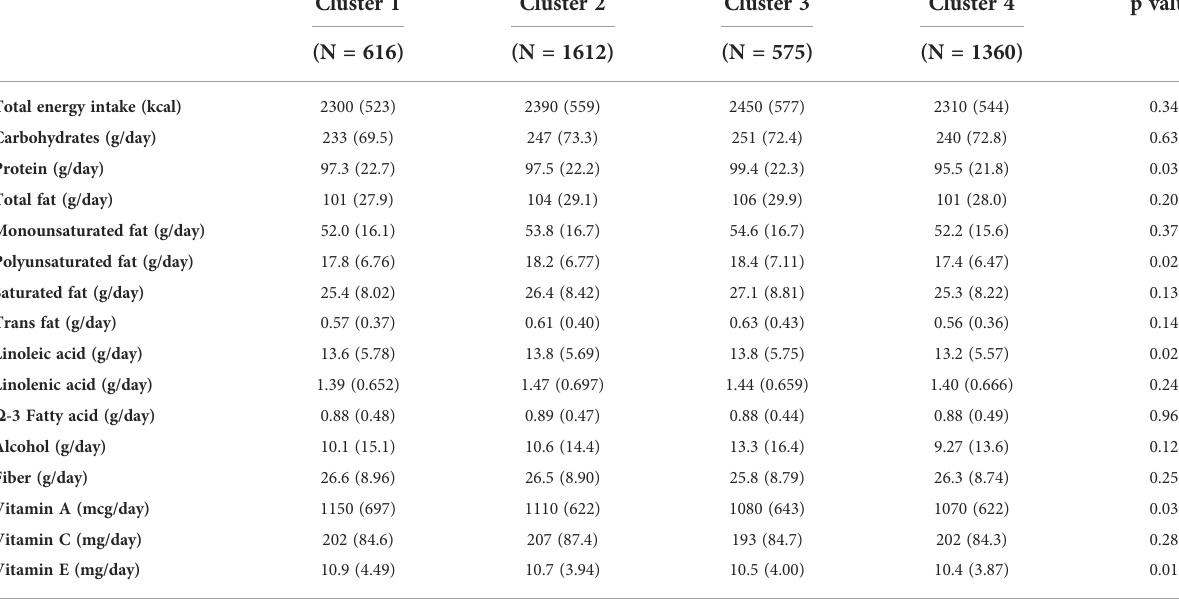
TABLE 4 Differences between clusters in energy and nutrient ’ s intake adjusted by sex, age and recruitment